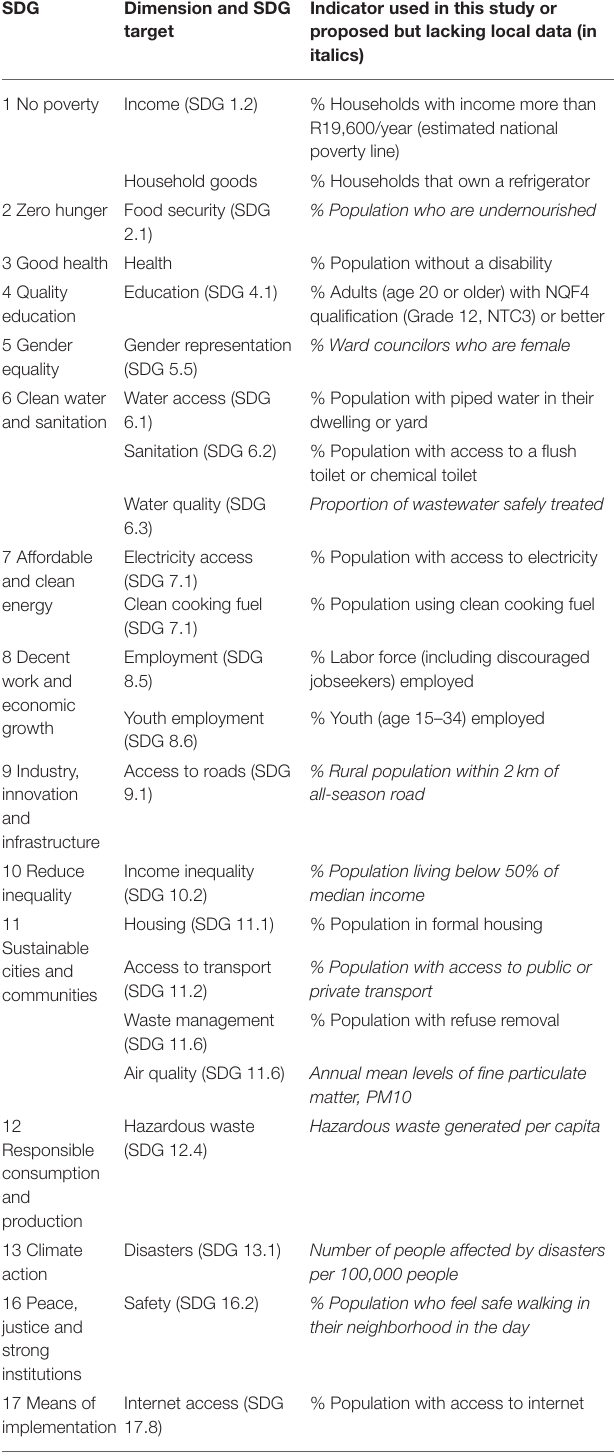
TABLE 4 | SDG indicators of well-being for mining host